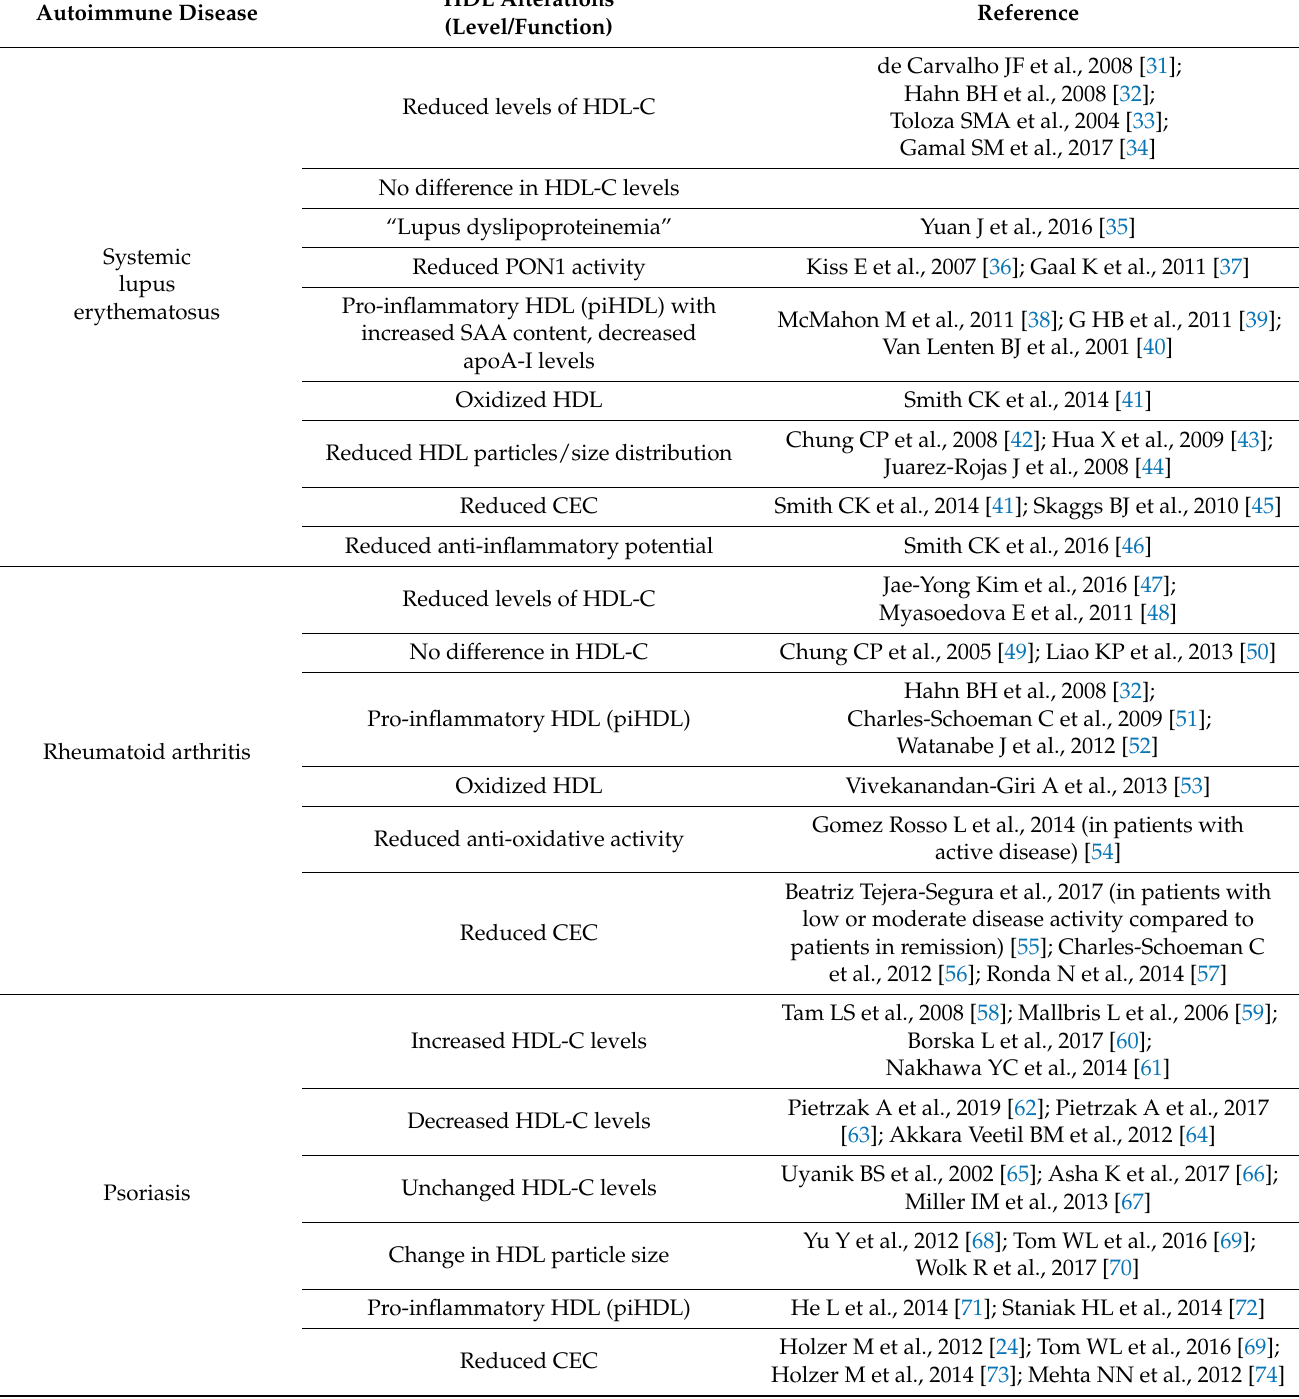
Table 1. Major HDL alterations in selected autoimmune